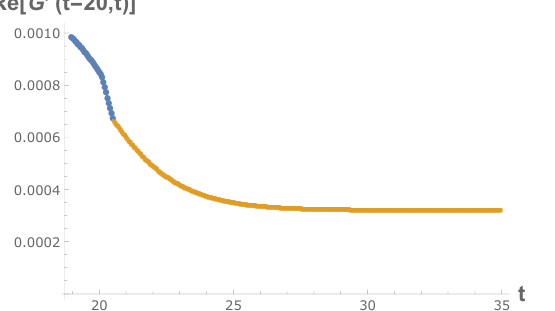
Figure 6. Plot of the real part of the greater Green’s function G > ( t − 20 , t ) as a function of t for a quantum quench starting from the liquid state. The Green’s function changes non-trivially even after both time argument have crossed the quench region (orange portion). The quench region is from t = 20 . 05 to t = 20 . 50